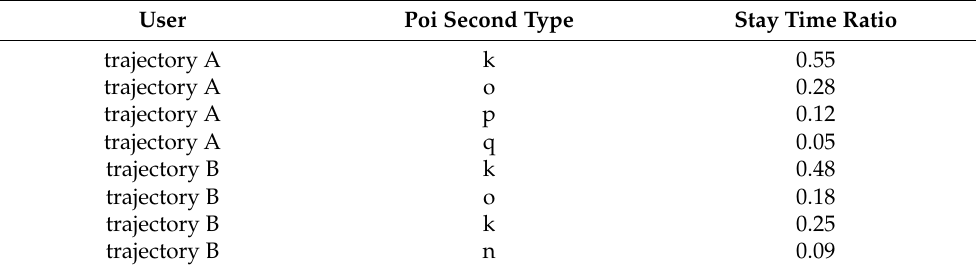
Table 7. Stay time ratios of trajectories A and B.